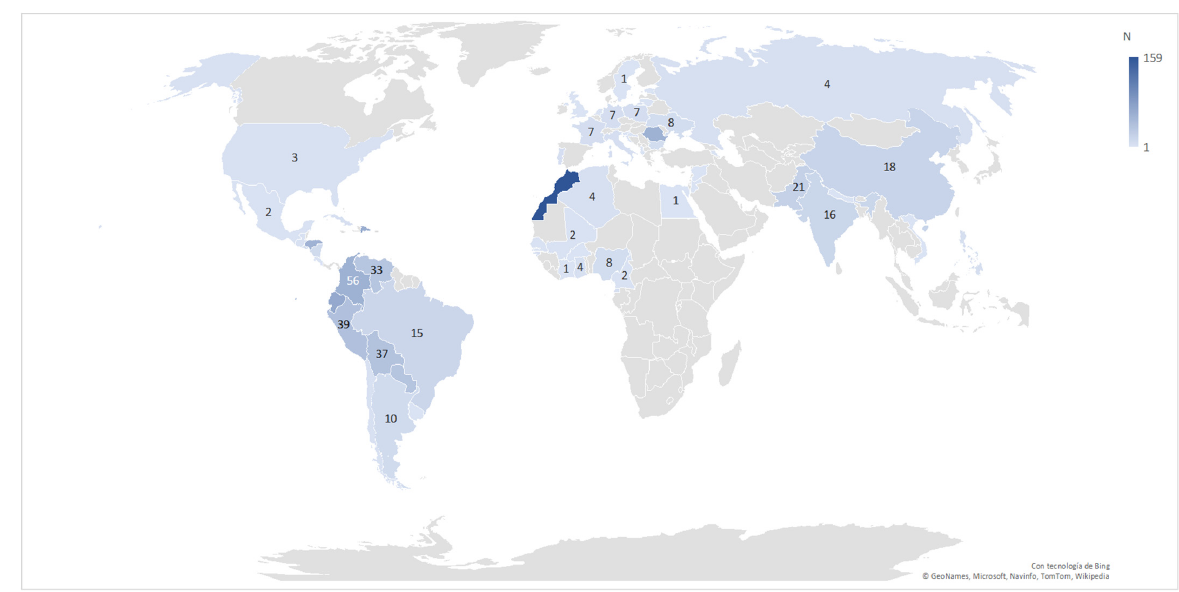
Figure 3. Cases of COVID-19 in pregnant women according to maternal country of origin. Table 2. Maternal and perinatal characteristics.